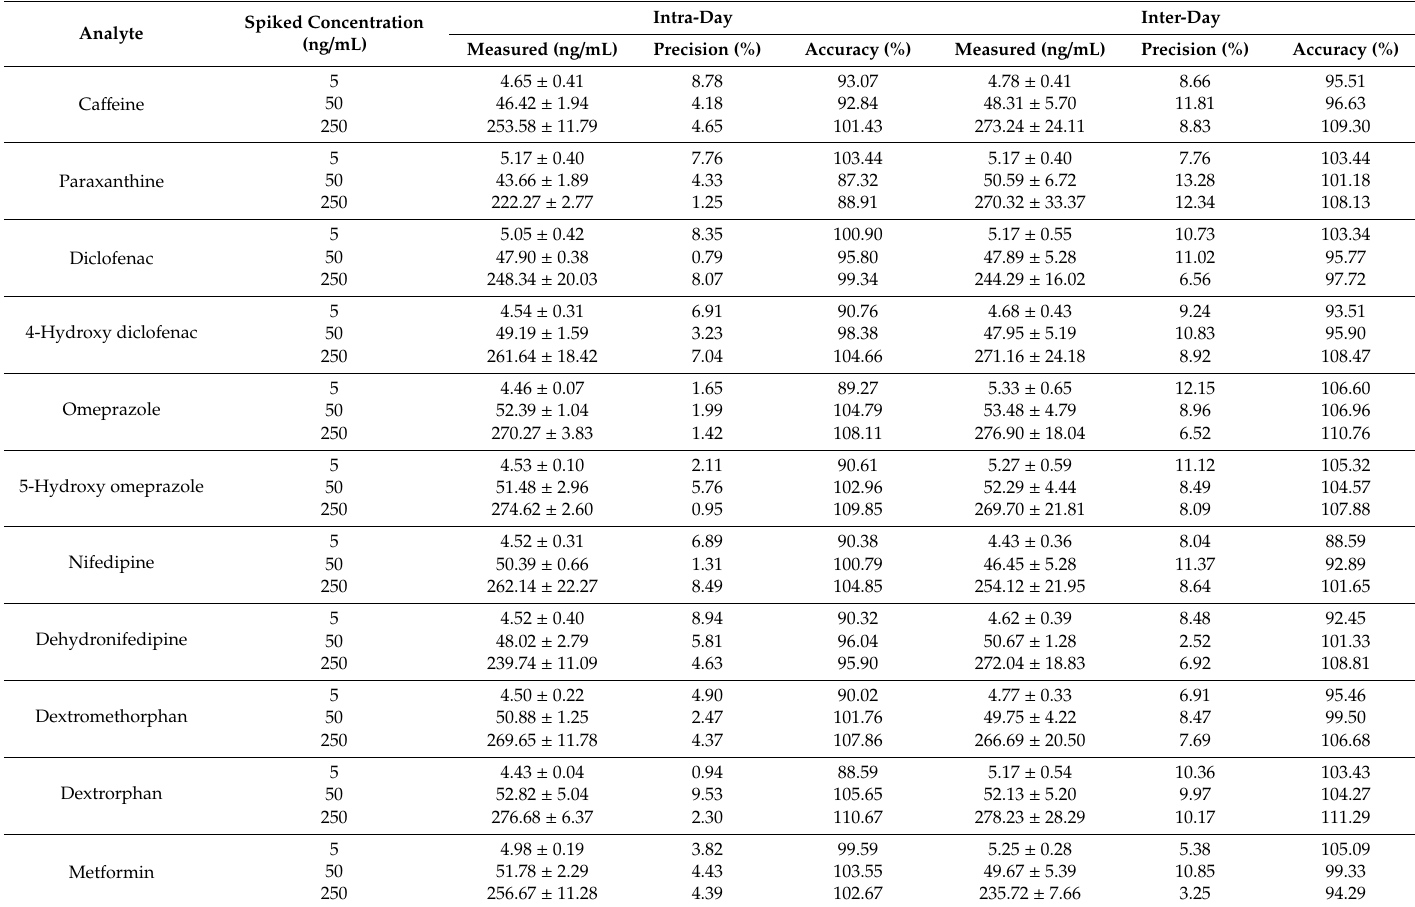
Table 3. Intra- and inter-day precision and accuracy of 15 probe substrates and